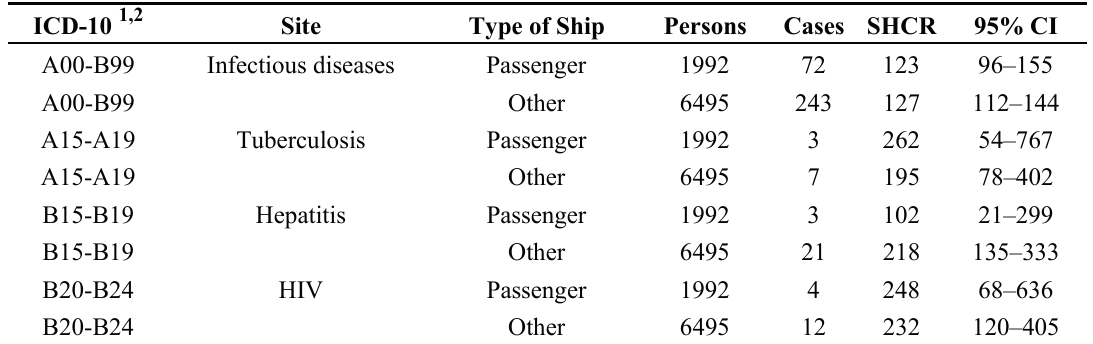
Table 5. Standardized hospital contact ratios (SHCR) for infectious diseases in 1994–2003 among Danish seafarers by type of ship